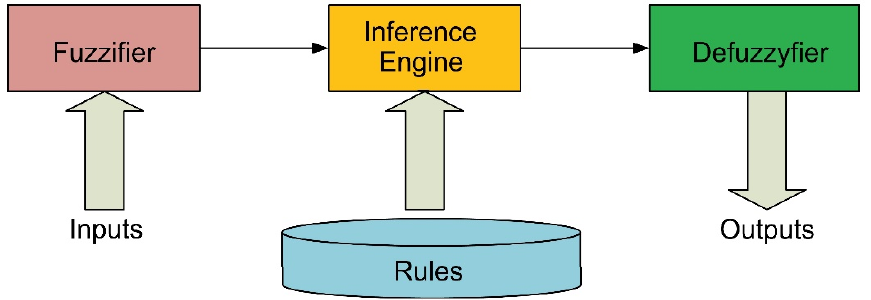
Figure 6. Overview of fuzzy logic